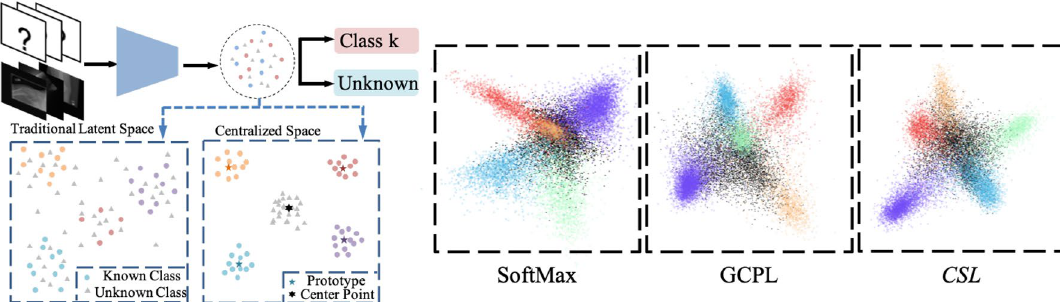
Figure 1. Left: open-set CAD task and CSL ; right: the learned latent distribution. In the traditional latent space learnt by conventional methods, the network tends to embed all samples, including samples from unknown classes, around the cluster of known classes. This makes separating the known from unknown classes even harder. In CSL , we propose to learn a centralized space with a prototype for each known class and a center point in the center. All samples from known classes are clustered around the corresponding prototype and the samples from unknown classes are clustered around the center Fig. 1, the restriction on known latent distribution also makes the network tend to embed unknown samples around the known classes, deteriorating the network’s separation ability.